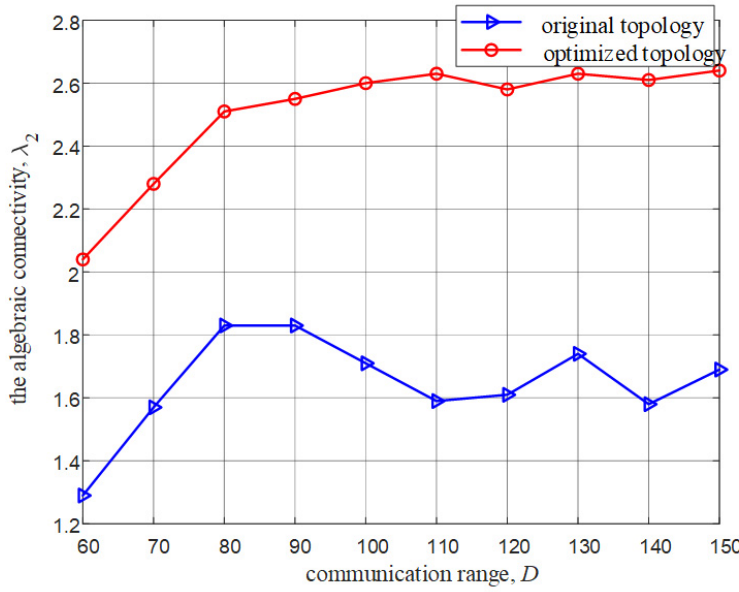
Figure 8. The impact of the communication range on the algebraic